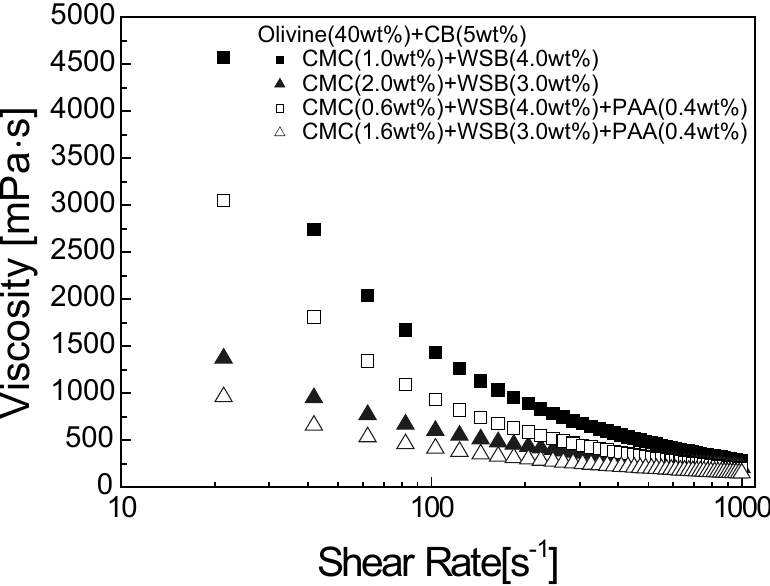
Fig. 3 Apparent viscosity vs. ascending shear rate for C/LiFePO 4 paste at a solid mass fraction of